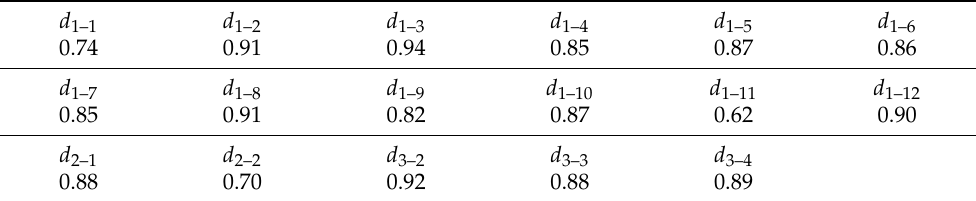
Table 9. Values of λ -cut matrix of each second-level